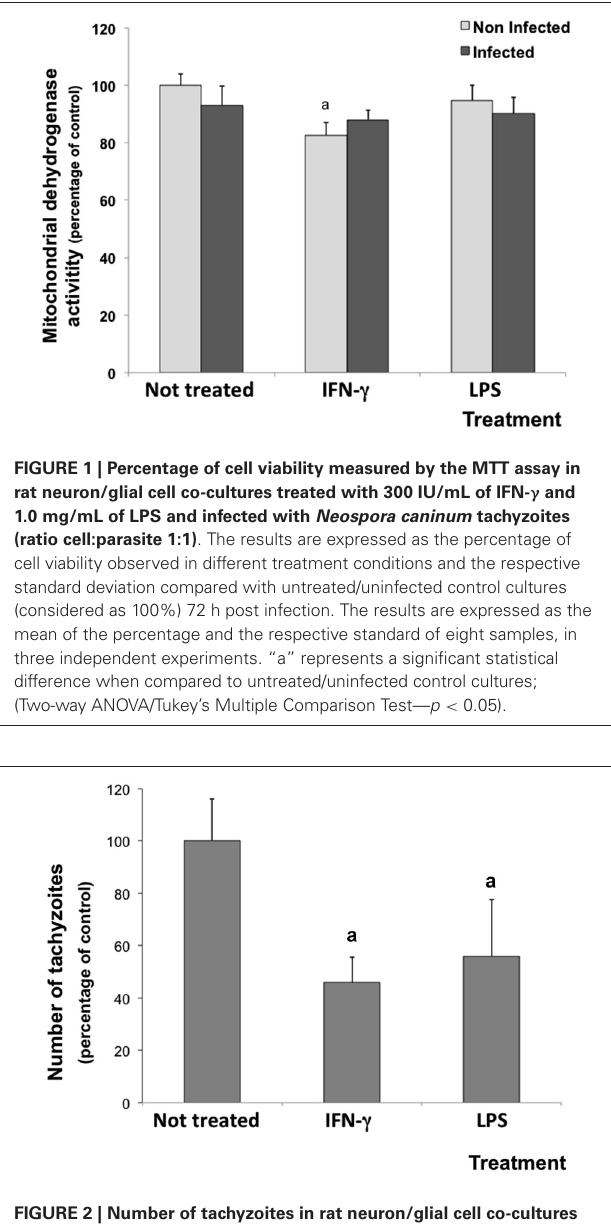
FIGURE 2 | Number of tachyzoites in rat neuron/glial cell co-cultures treated with 300 IU/mL IFN- γ or 1.0 mg/mL LPS and infected with Neospora caninum tachyzoites (ratio cell:parasite 1:1), 72 h post infection . Results are expressed as means ( ± standard deviations) of tachyzoite percentages compared to non-treated/infected control cultures (considered as 100%) in three independent experiments carried out in triplicate. “a” represents a significant statistical difference when compared to not treated/infected cultures (One Way ANOVA/Tukey’s Multiple Comparison Test— p < 0.05).